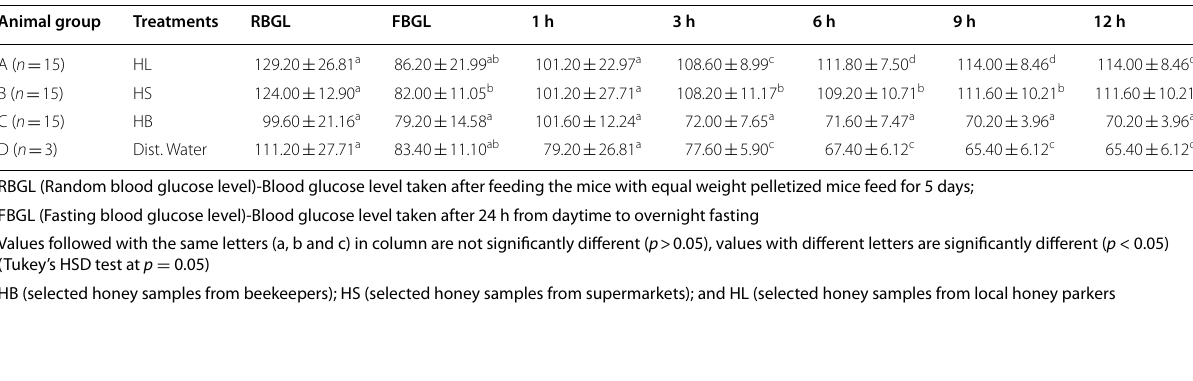
Table 2 Blood glucose level (BGL) before and after treatments in mice Animal group